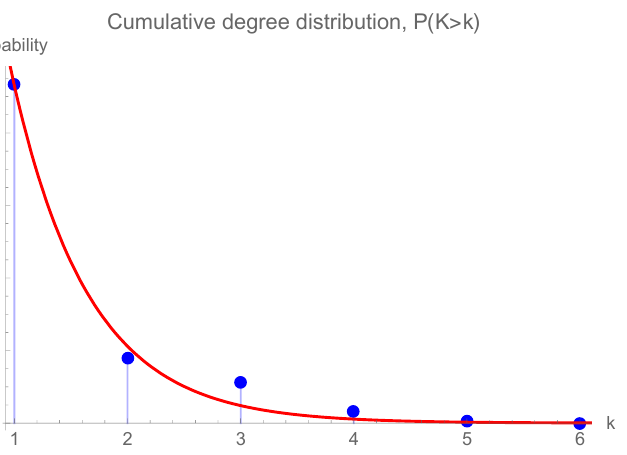
Figure 8. Cumulative degree distribution of Barcelona subway